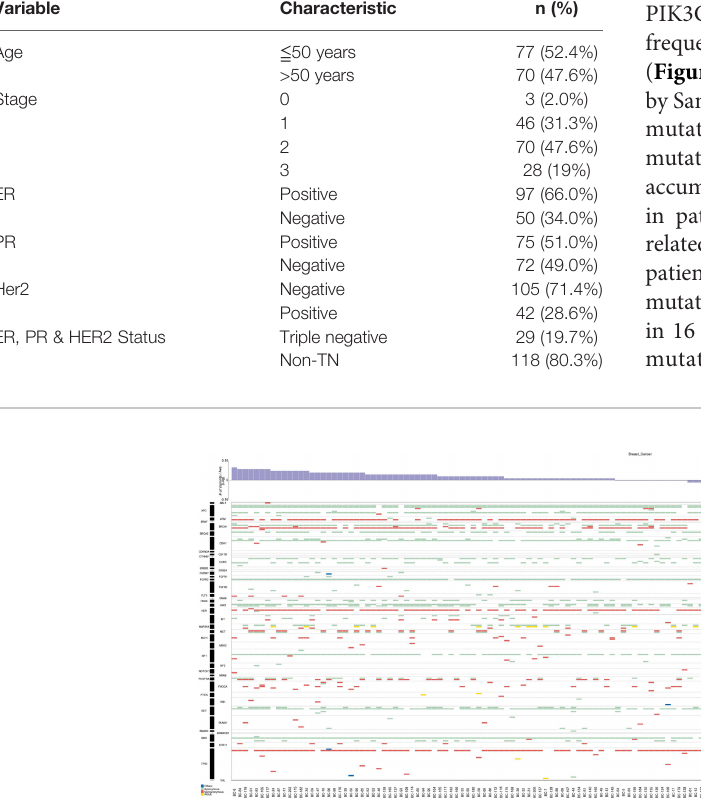
FIGURE 1 | Mutations and in the 147 breast cancer patients. The top panel shows a summary of the mutations in 43 cancer hotspot genes (see text and Table S2 for details). Patients are arranged from left to right by the number of mutations, shown in the top track. Colored rectangles indicate the mutation category observed in a given